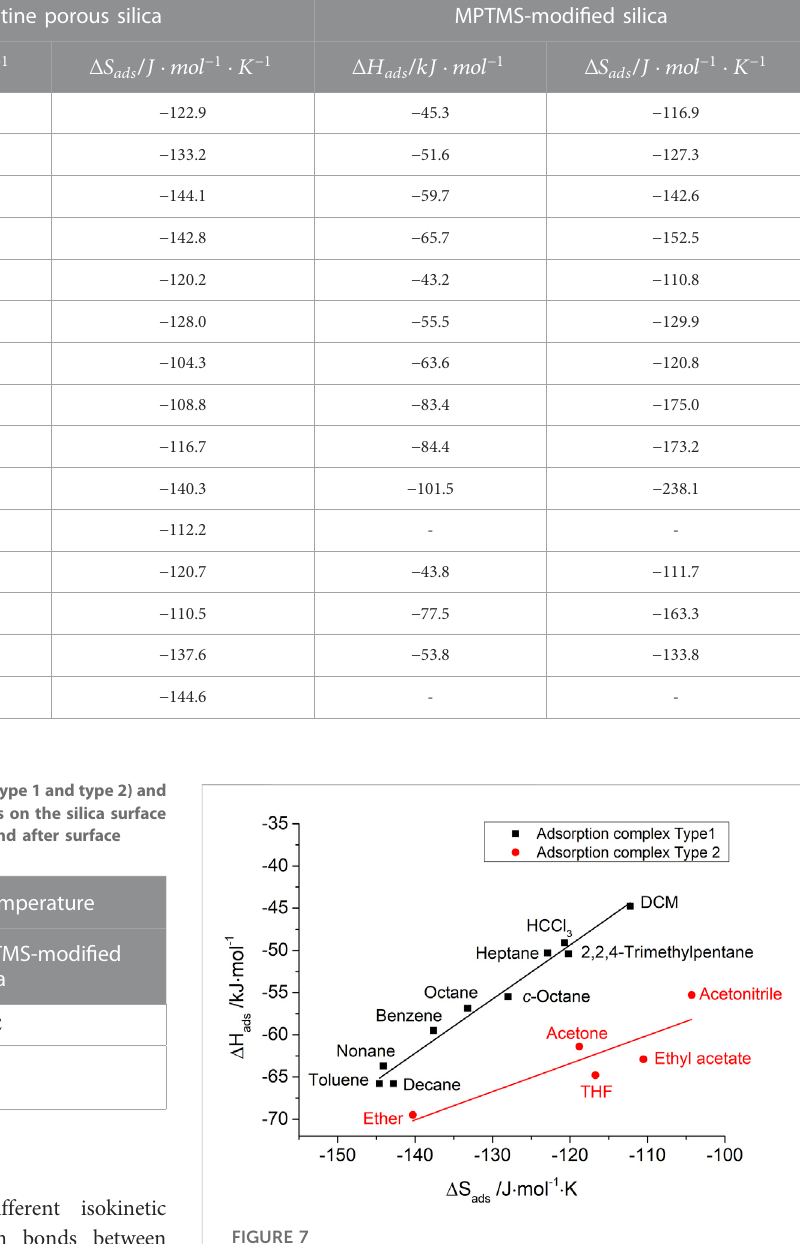
FIGURE 7 Enthalpy – entropy compensation for probe molecules with two types of adsorption complexes on pristine porous